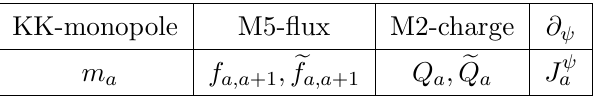
Table 1 . Relation between residues in the functions H and charges of M-theory